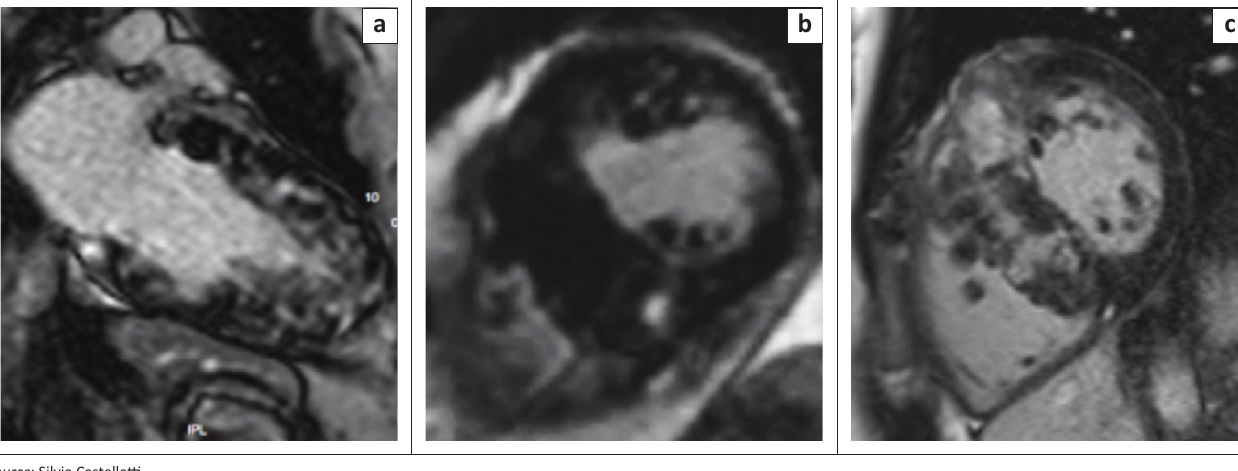
FIGURE 7: Patterns of LGE. (a) Two-chamber view in apical HCM-note heterogeneous LGE in mid to apical LV. (b) Mid short-axis (SAX) slice in septal HCM-focal inferior LV/ RV insertion point LGE. (c) Basal SAX in septal HCM-patchy septal